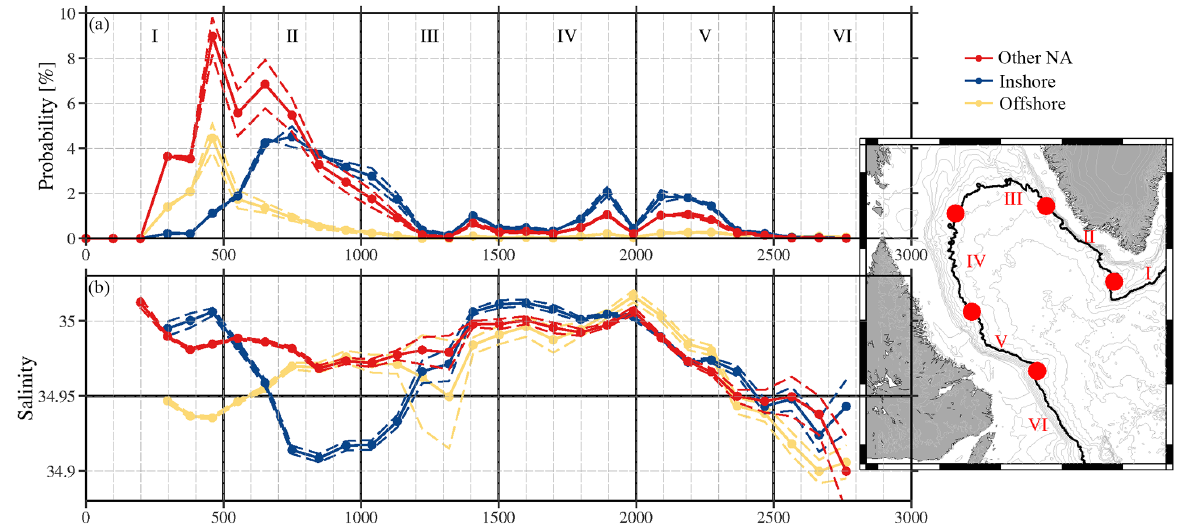
Figure 5. (a) The probability of crossings per 100km section (solid line) and the estimated error (dashed line). (b) The average salinity of the crossing particles at each 100km section (solid line) and the associated error (dashed lines). The black horizontal line shows the reference salinity of 34.95 that is used to calculate the freshwater flux. In both panels the vertical lines correspond to the location of the red circles on the map to help orient the reader geographically. Red lines show the EGC offshore water, blue the EGC inshore water, and yellow the water from other regions of the North Atlantic.